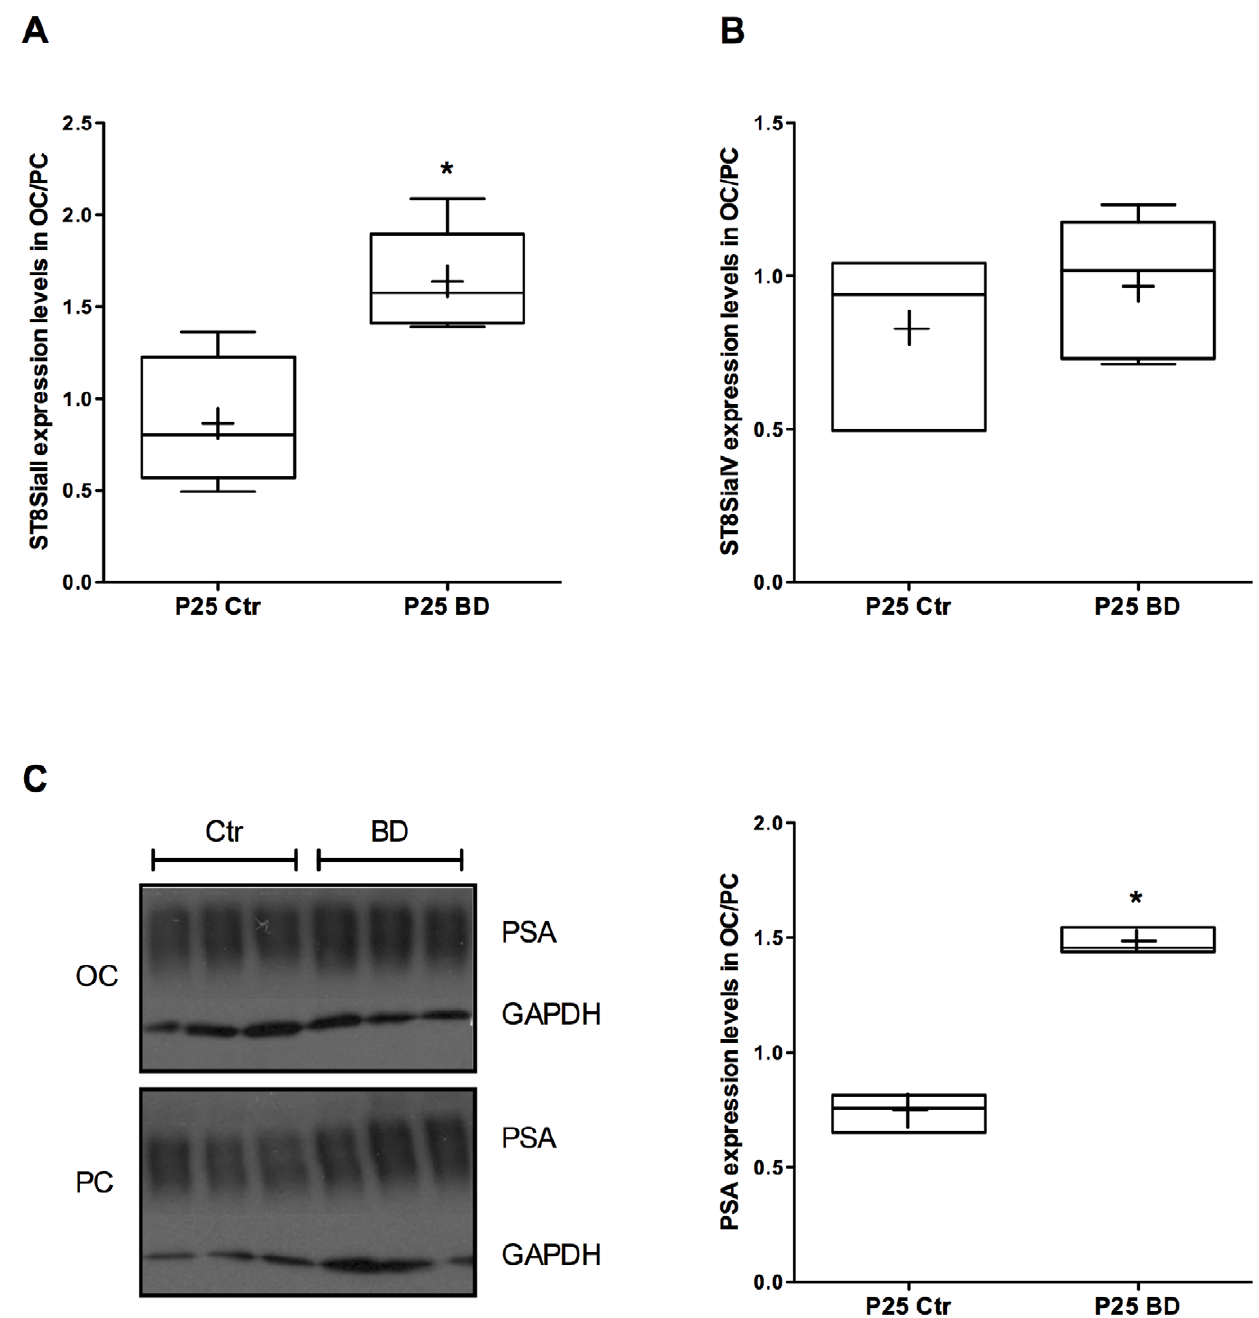
Figure 2. Sensory experience regulates ST8SiaII, but not ST8SiaIV, mRNA levels invivo . (A–B) ST8SiaII (A), but not ST8SiaIV (B), mRNA levels are significantly higher in visual cortex from mice binocularly deprived (BD) from P13-25 (Mann Whitney-test, *p , 0.01; n=4 for Controls and n=5 for BD animals). For each animal, ST8SiaII and ST8SiaIV expression levels in visual cortex (OC) are normalized to those found in parietal cortex (PC). (C) Left, immunoblot analysis of mouse visual cortex (OC) and parietal cortex (PC) using anti-PSA and anti-GAPDH antibodies. Right, quantification of PSA expression levels in mouse visual cortex (OC) normalized to parietal cortex (PC). PSA developmental down-regulation is impaired in binocular deprived animals (Mann-Whitney -test, *p , 0.01; n=3 for both Controls and BD animals). The cross in the graph represents the average, while the horizontal bar is the median value. The box shows the interquartile range, which is used as a measure of data spread - spanning 50% of a data set and eliminating the influence of outliers. The whiskers go down to the smallest value and up to the largest. When n=3 or lower, there is no whiskers and the floating bar represents the maximum and the minimum values.